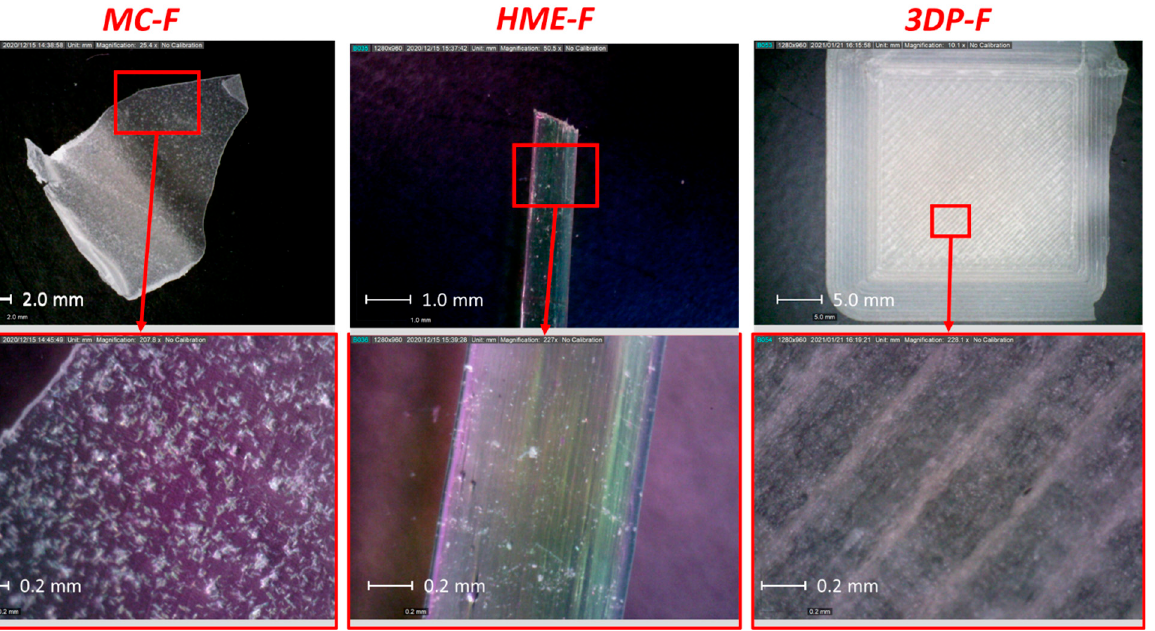
Figure 9. The demonstration of the MC-F, HME-F, 3DP-F under the optical microscope and polarized light microscope.